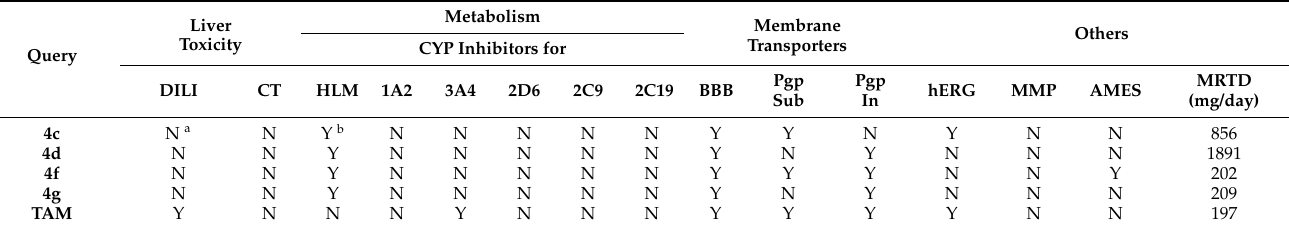
Table 2. The vNN-ADMET predictions for the ATBA